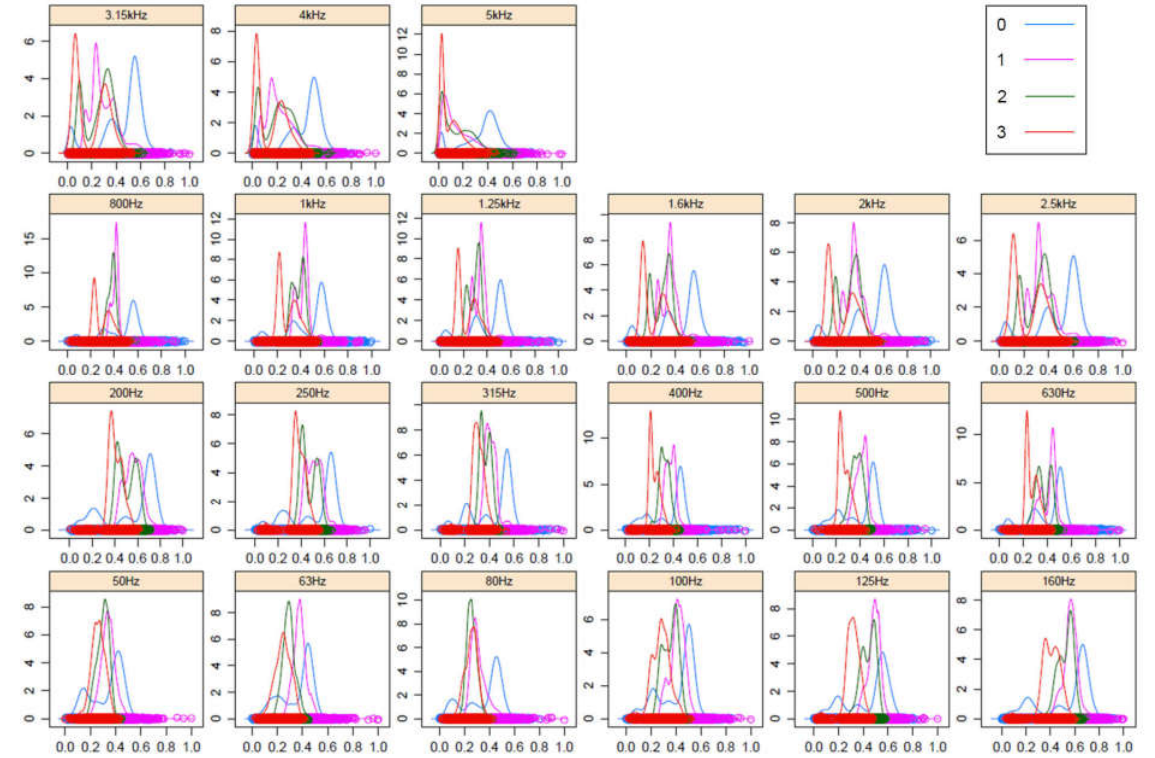
Figure 6. Density lattice plots of average spectral levels in one-third octave band. 0 = all turbines off, 1 = all turbines on, 2 = one turbine off, 3 = two turbines off.